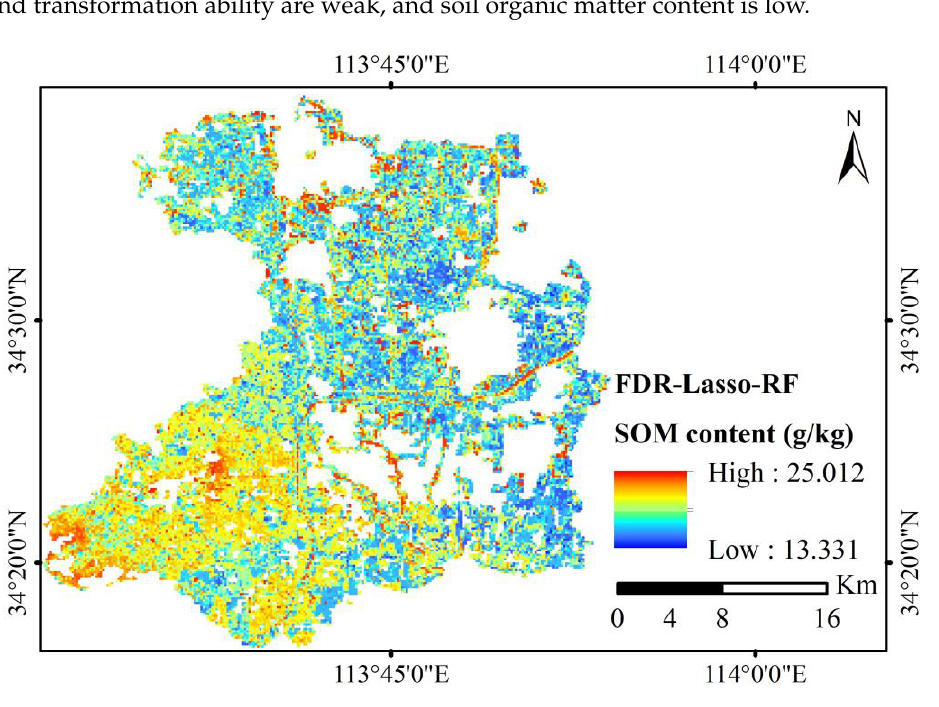
Figure 10. Optimal model predicts SOM content for study